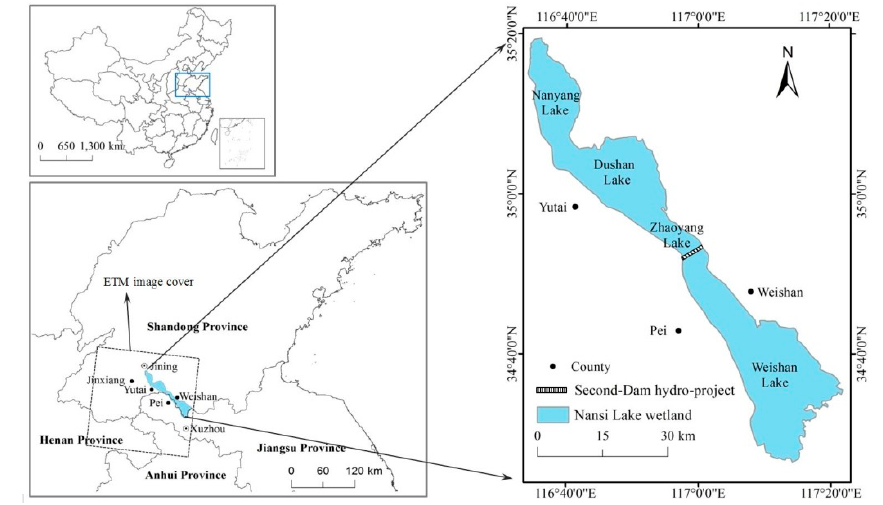
Figure 1. Location and composition of Nansi Lake wetland.